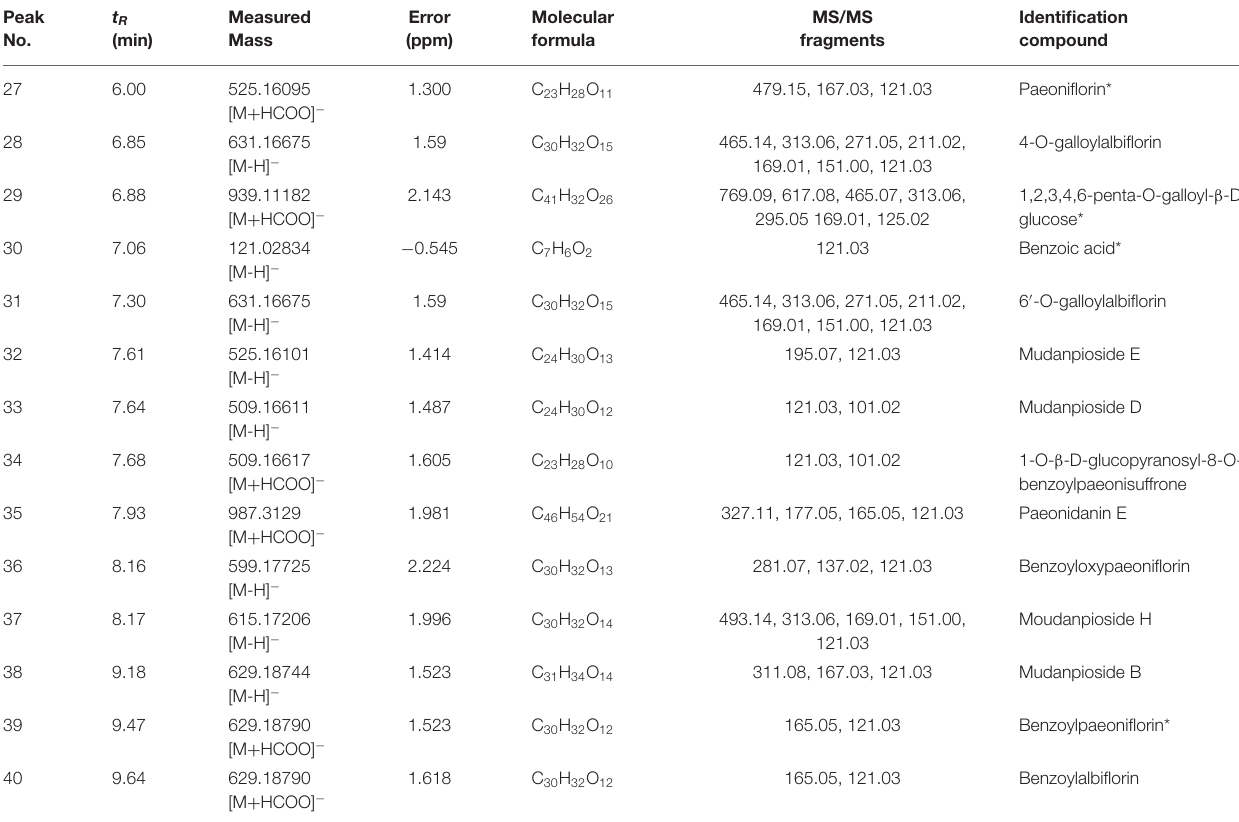
Table 3 . By use of MedChem Studio, 377 putative targets for PRA were obtained as listed in Supplementary Table 1